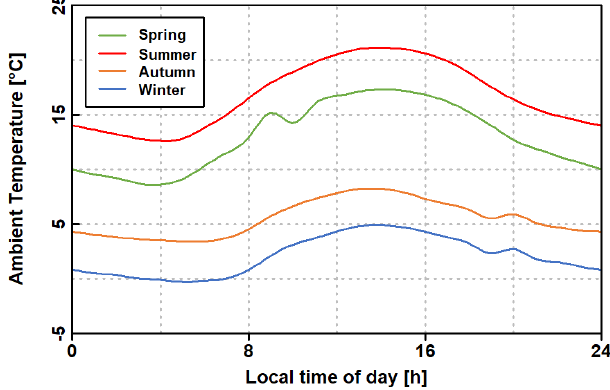
Figure 3. HBEFA mean seasonal diurnal temperature profiles for